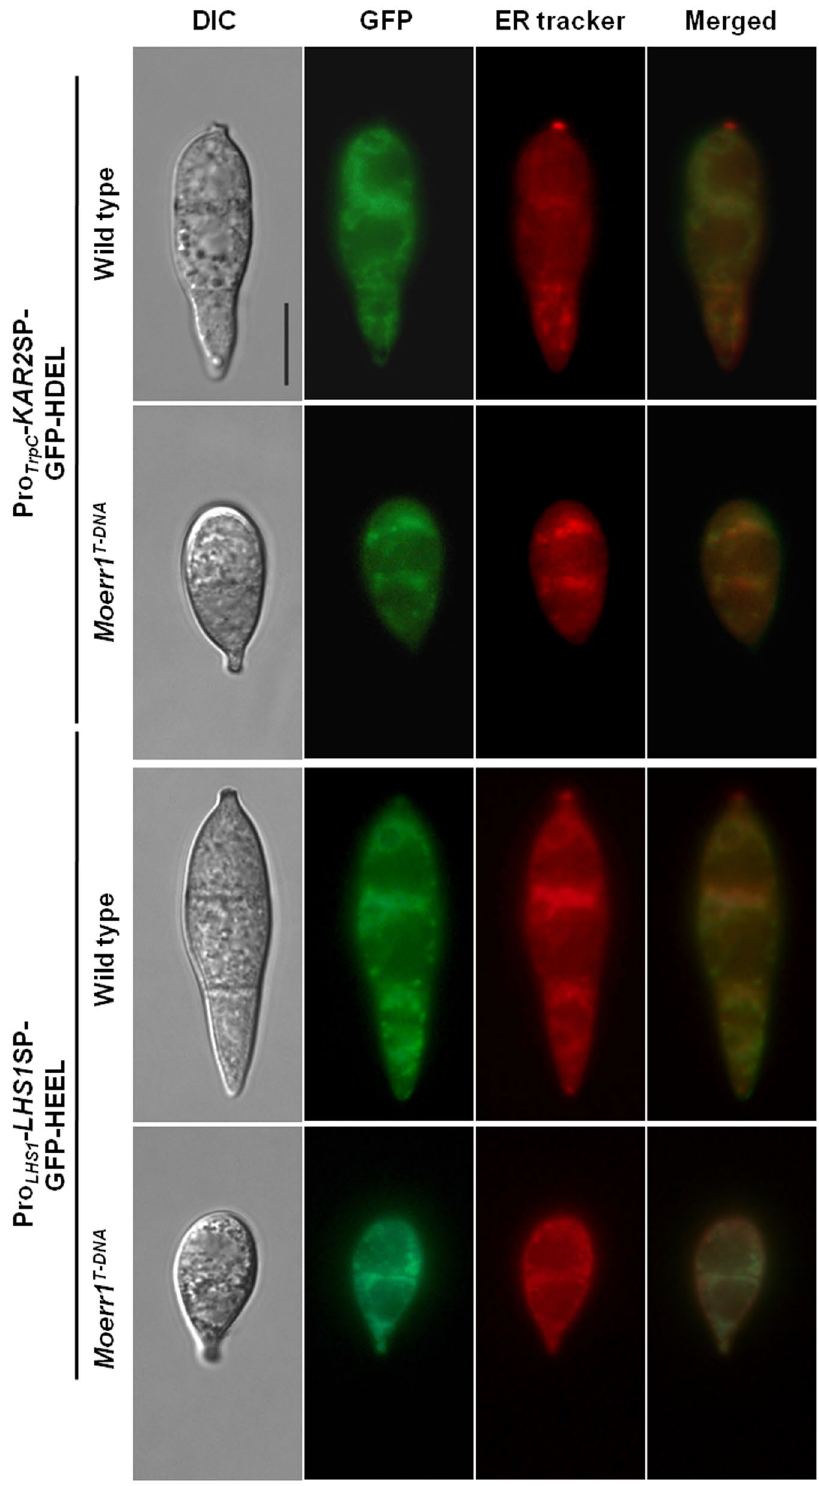
Figure 7. Cellular localization of eGFP-HDEL and eGFP-HEEL in conidia. GFP with ER retention signal construct was designed to have GFP tagging with HDEL/HEEL in N-terminal and signal peptide of LHS1 or KAR2 in C-terminal. Bar = 10 μ